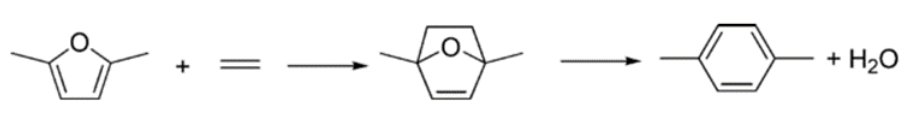
Figure 5. Production of ρ -xylene via Diels – Alder cycloaddition with ethylene and subsequent dehydration.